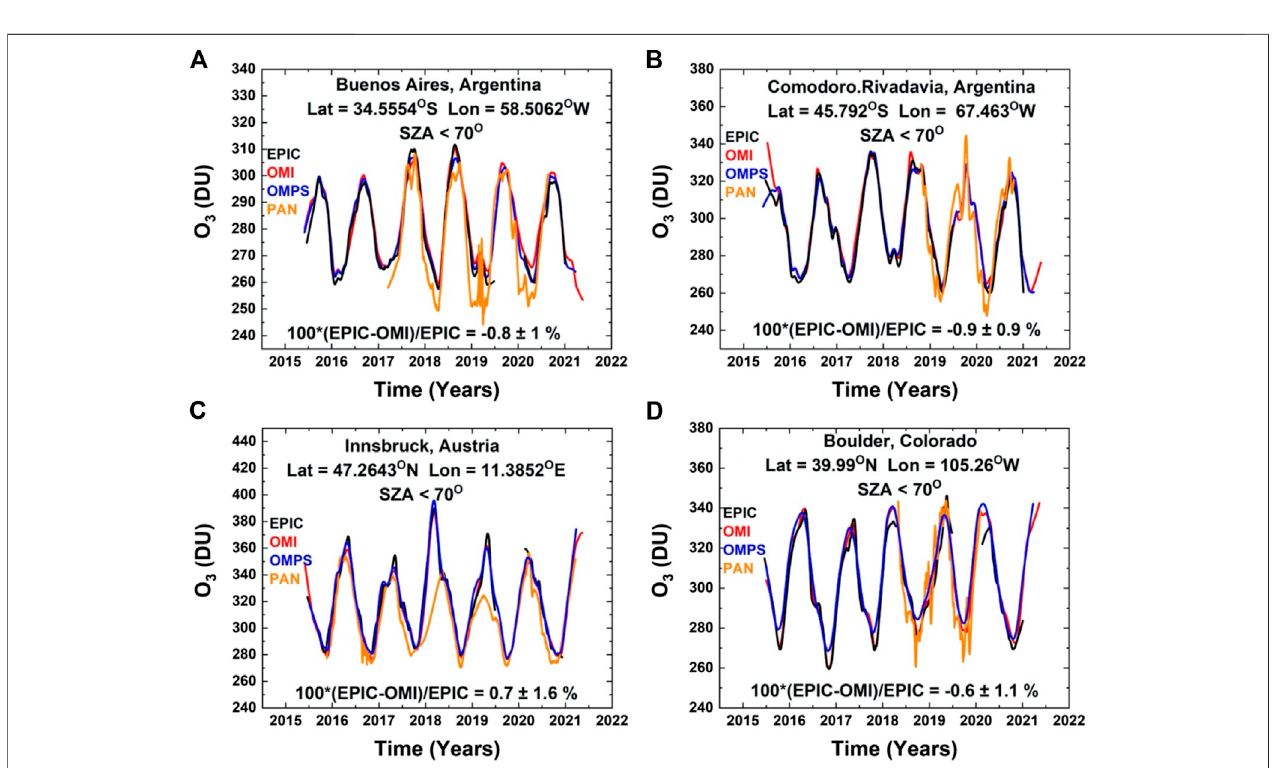
FIGURE 9 | A comparison of EPIC TOZ time series (black) with Pandora (red), OMI (blue) and OMPS (orange) at four ground-based stations: Buenos Aires, Argentina (A) , Comodoro, Argentina (B) , Innsbruck, Austria (C) , and Boulder, Colorado United States (D) . The lines are a Local-Linear Least-Squares (LOESS) fi t to the data (Cleveland, 1979) equivalent to approximately a 3-months running average. The biases between EPIC and OMI (in %), indicated in each panel, are done for 3- months averages. EPIC data had been screened as described in Earth Polychromatic Imaging Camera Total Ozone .